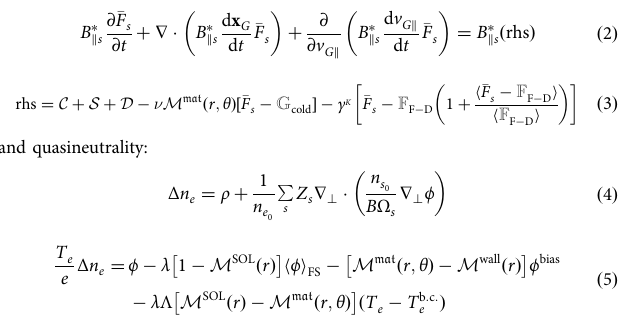
penalised heat and momentum sinks M mat ð r ; θ Þ , M SOL ð r Þ and M wall ð r Þ that can mimic from poloidally-uniform boundary conditions (Case-2) to the more complex